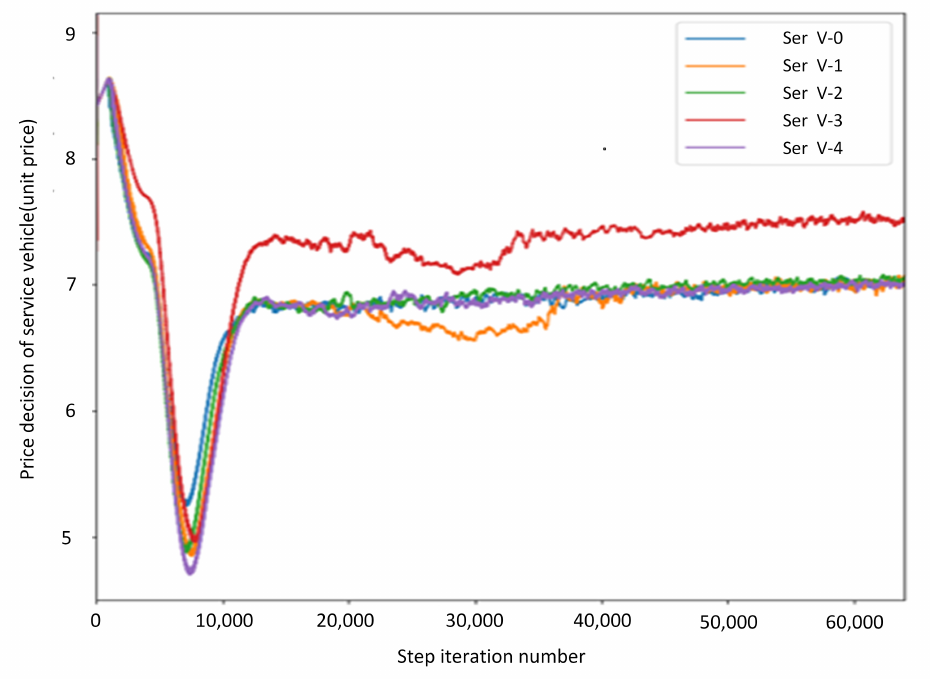
Figure 4. Price decision for service